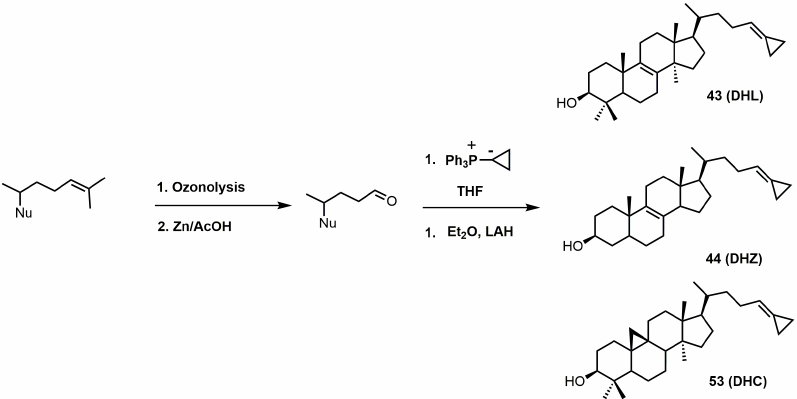
Figure 25. Synthesis of cyclopropylidine sterol derivatives. Nu: sterol nucleus (cycloartenol, lanosterol, or zymosterol).